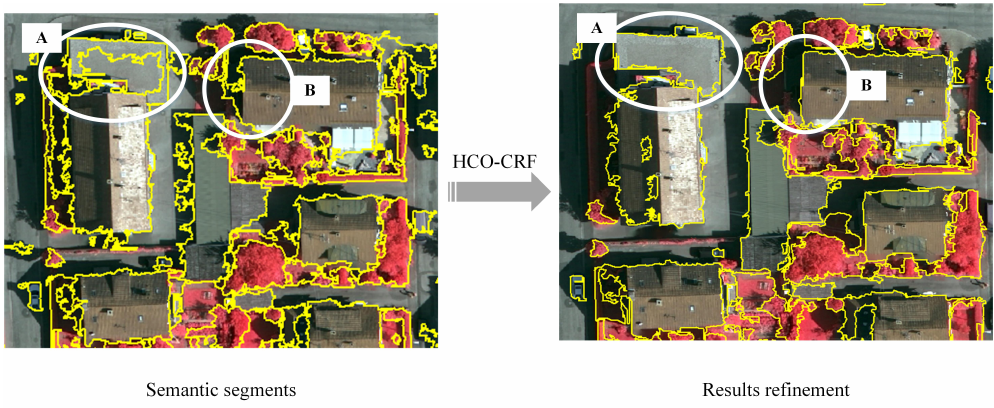
Figure 3. The illustration of HCO-CRF improvements. Based on the semantic segments, the initial classification result (left) can be further refined according to the co-occurrence matrix between classes